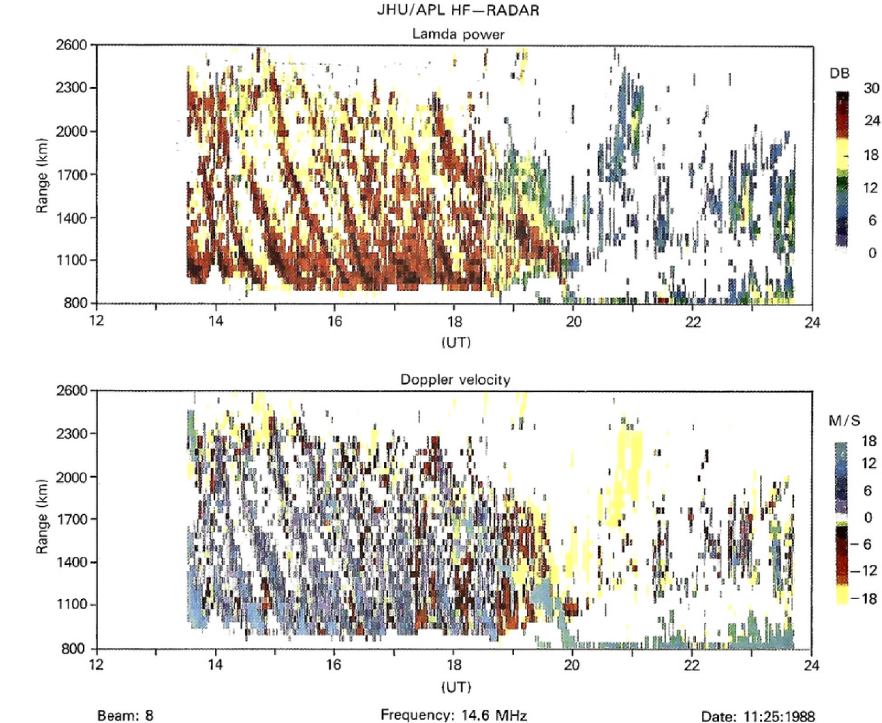
Figure 13. Range–time plot of PWR_L in dB and Doppler velocity. Note the equatorward-moving strong intensifications in backscattered power that are associated with low Doppler velocities. These intensifications are due to Earth-reflected atmospheric gravity waves that are produced at high latitudes and propagate equatorward and downward. After being reflected by the Earth, they return to the ionosphere where they create a pattern of southward-moving neutral density enhancements in the ionosphere. These, in turn, create a southward-moving corrugated electron density pattern on the bottomside of the ionosphere. Further details are given in Fig. 14. Reproduced from plate 3 of Samson et al.